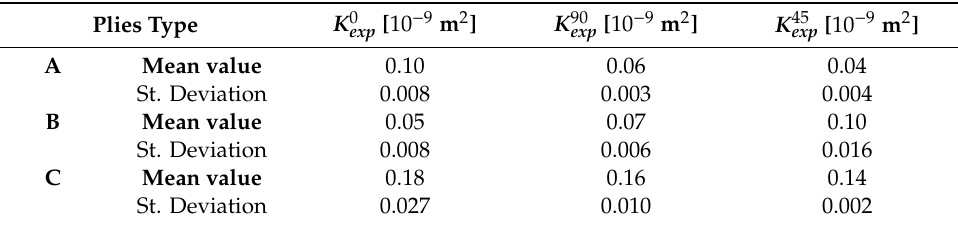
Table 6. Local permeability of the carbon textile.